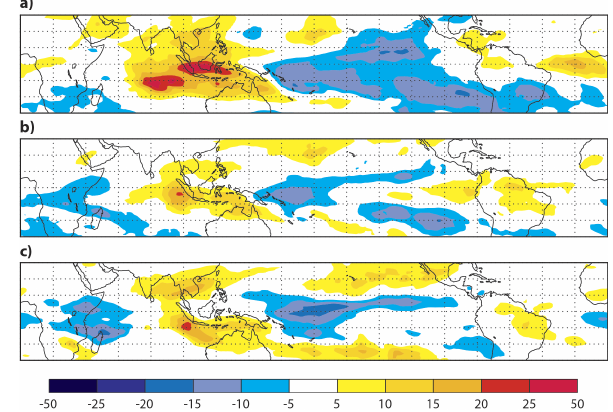
Figure 5. O 3 anomaly at 500 hPa in ppb calculated from the MACC reanalysis as the difference of El Niño composite minus La Niña composite for October (a) , November (b) and December (c) . Red colours indicate positive values and blue colours negative